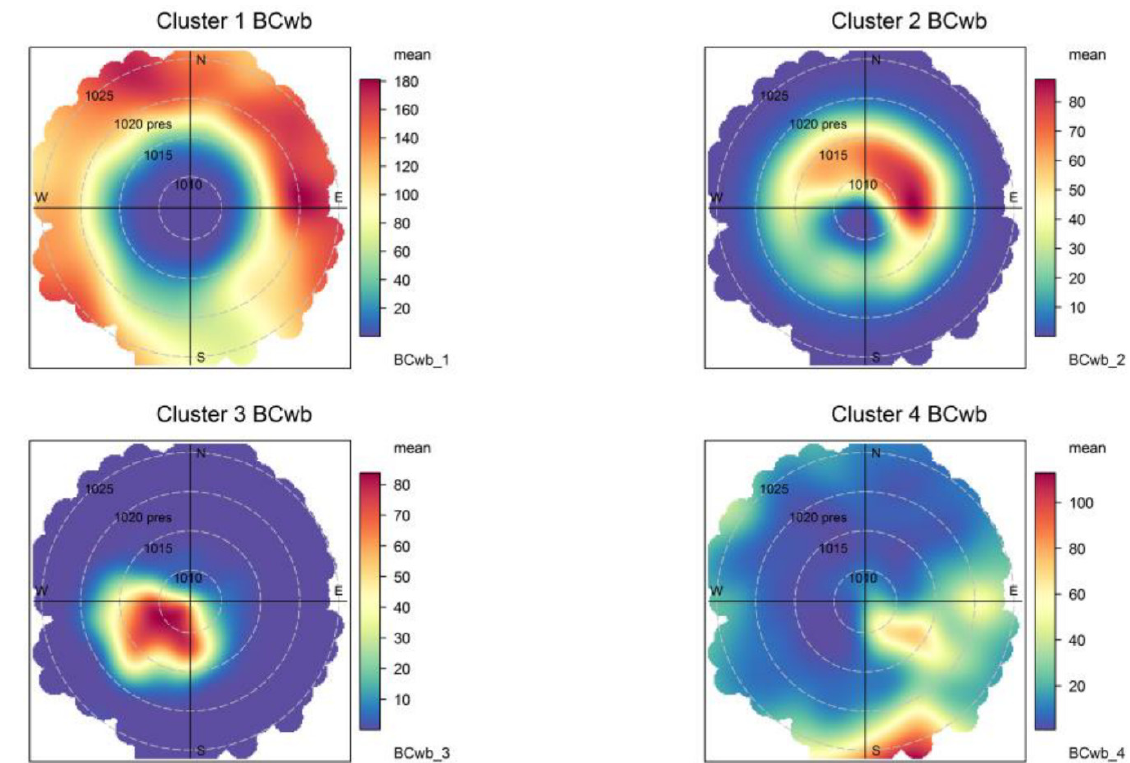
Figure A6. Bivariate plot of hourly BC wb contributions, 2020 campaign, using temperature instead of wind speed.